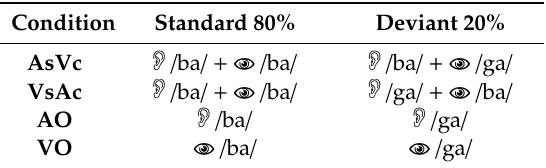
Table 1. Schematic of standards and deviants in each condition in the passive oddball paradigm: auditory steady–visual change (AsVc); visual steady–auditory change (VsAc); auditory-only (AO); and visual-only (VO).